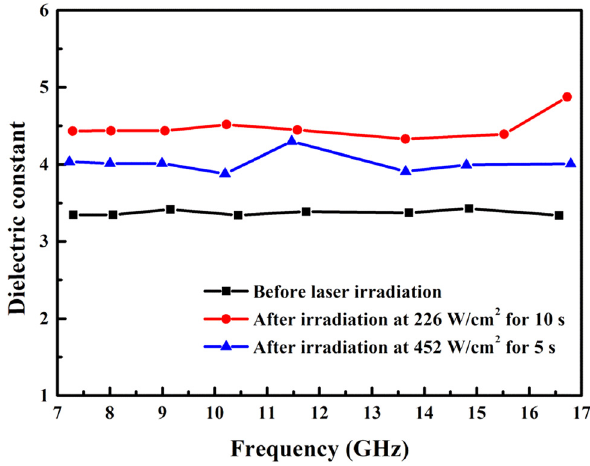
Figure 6: The dielectric constant of the quartz/epoxy composites before and after